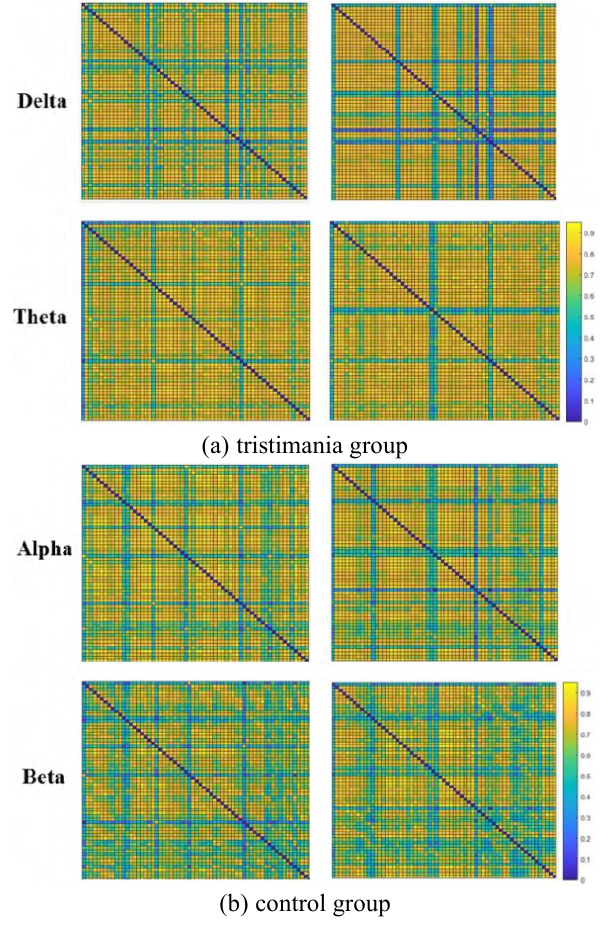
Figure 7. The position of 62 EEG Electrodes